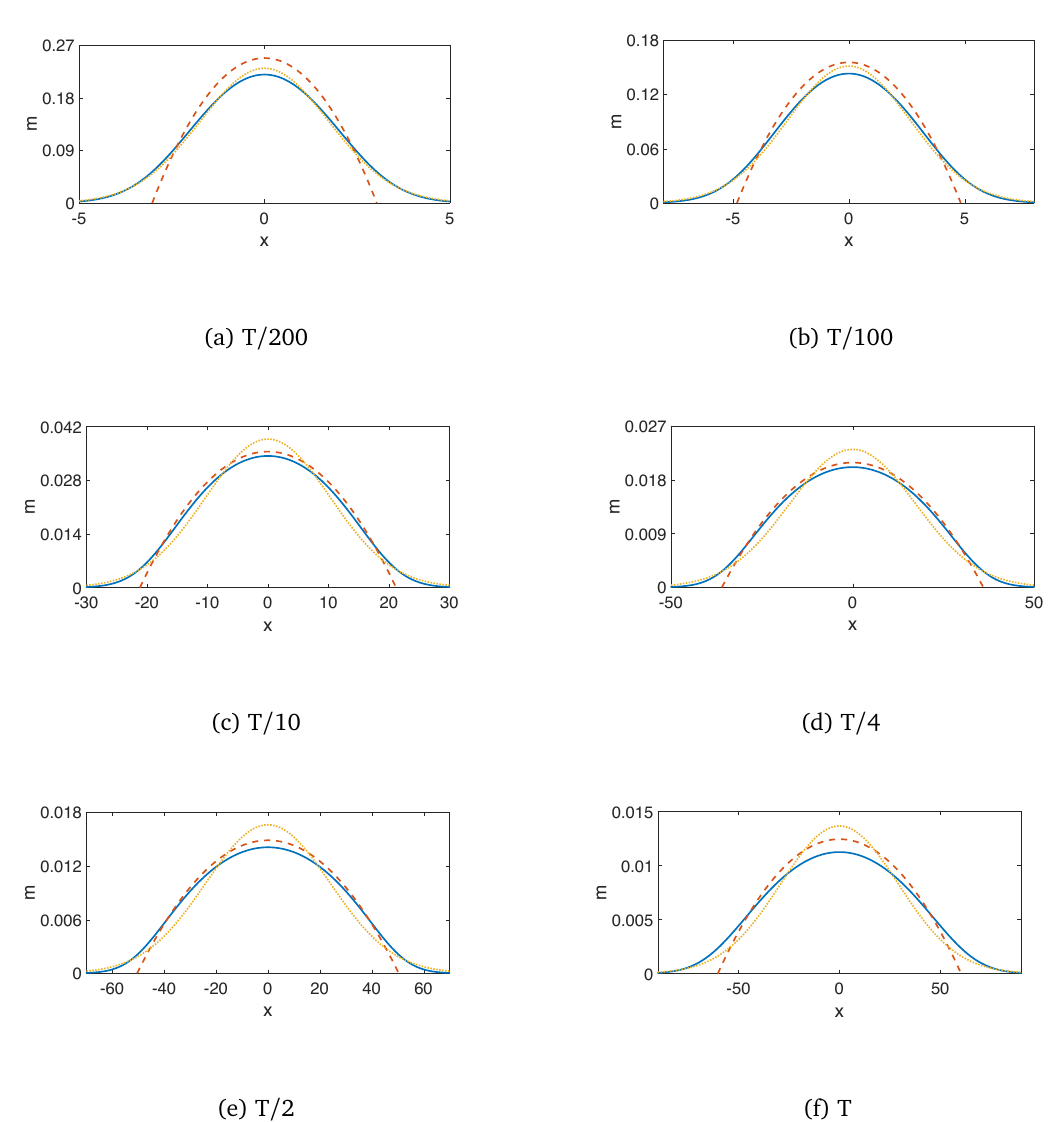
Figure 6: Density of players at different times, numerical results are plotted (solid line) along with the Gaussian (dotted line) and the parabolic ansatz (dashed line). At the beginning of the game, Figs (6a) and (6b), the Gaussian ansatz is the most accurate. Then in the middle of the game, Figs (6c) and (6d), the parabolic con- stitutes a better approximation. At the end of the game, Figs (6e) and (6f), the parabolic ansatz becomes less and less accurate as we near the terminal condition. = 0.2 and T = 300, while E = − 9.95 × 10 − 3 Here g = − 2, σ = 1.2, µ = 1, ν = 1, Σ 0 has been computed through the self-consistent